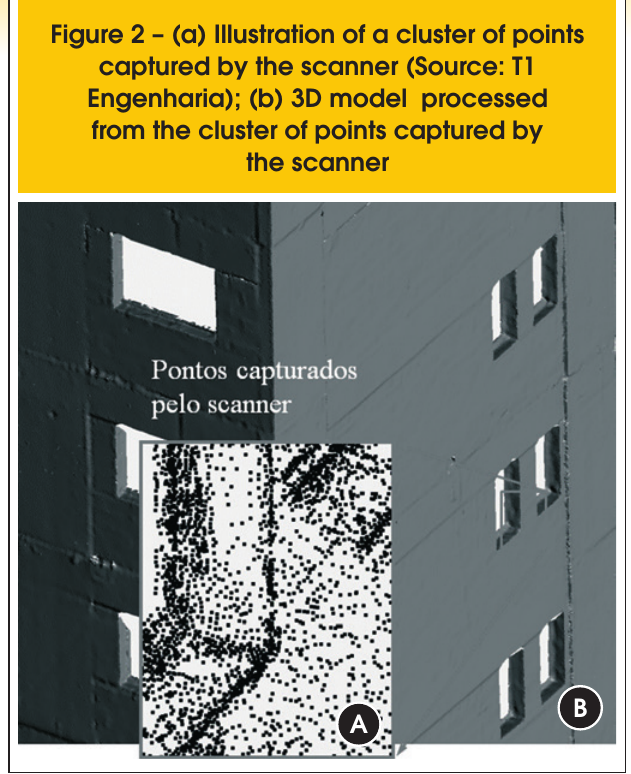
Figure 2 – (a) Illustration of a cluster of points captured by the scanner (Source: T1 Engenharia); (b) 3D model